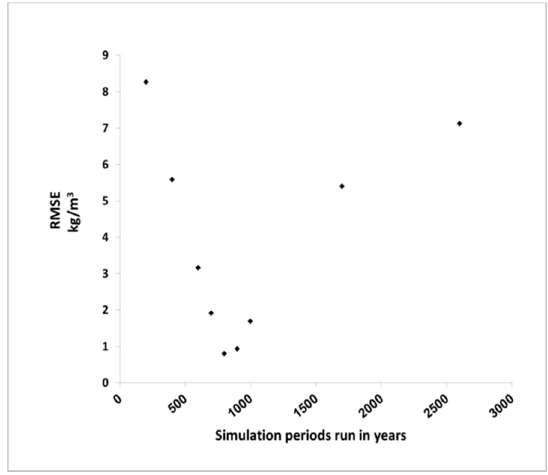
Figure 5. Root Mean Square Error (RMSE) of salinity values for different simulation periods.